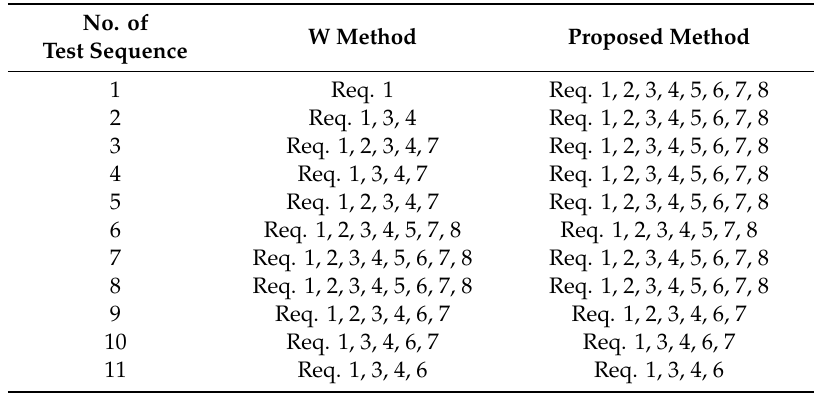
Table 7. Covered